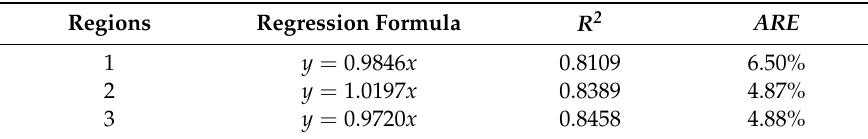
Figure 7. Regression analysis and error estimation: ( a ) region 1; ( b ) region 2; and ( c ) region 3. Table 1. Regression formulas and error analysis.